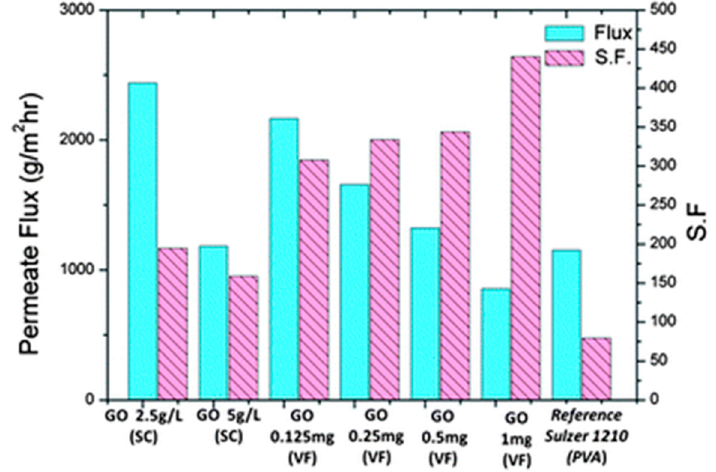
Figure 17. Permeate flux and separation factor (SF) brought about by the dehydration of ethanol via pervaporation using an 80 wt% ethanol feed solution at 70 °C.